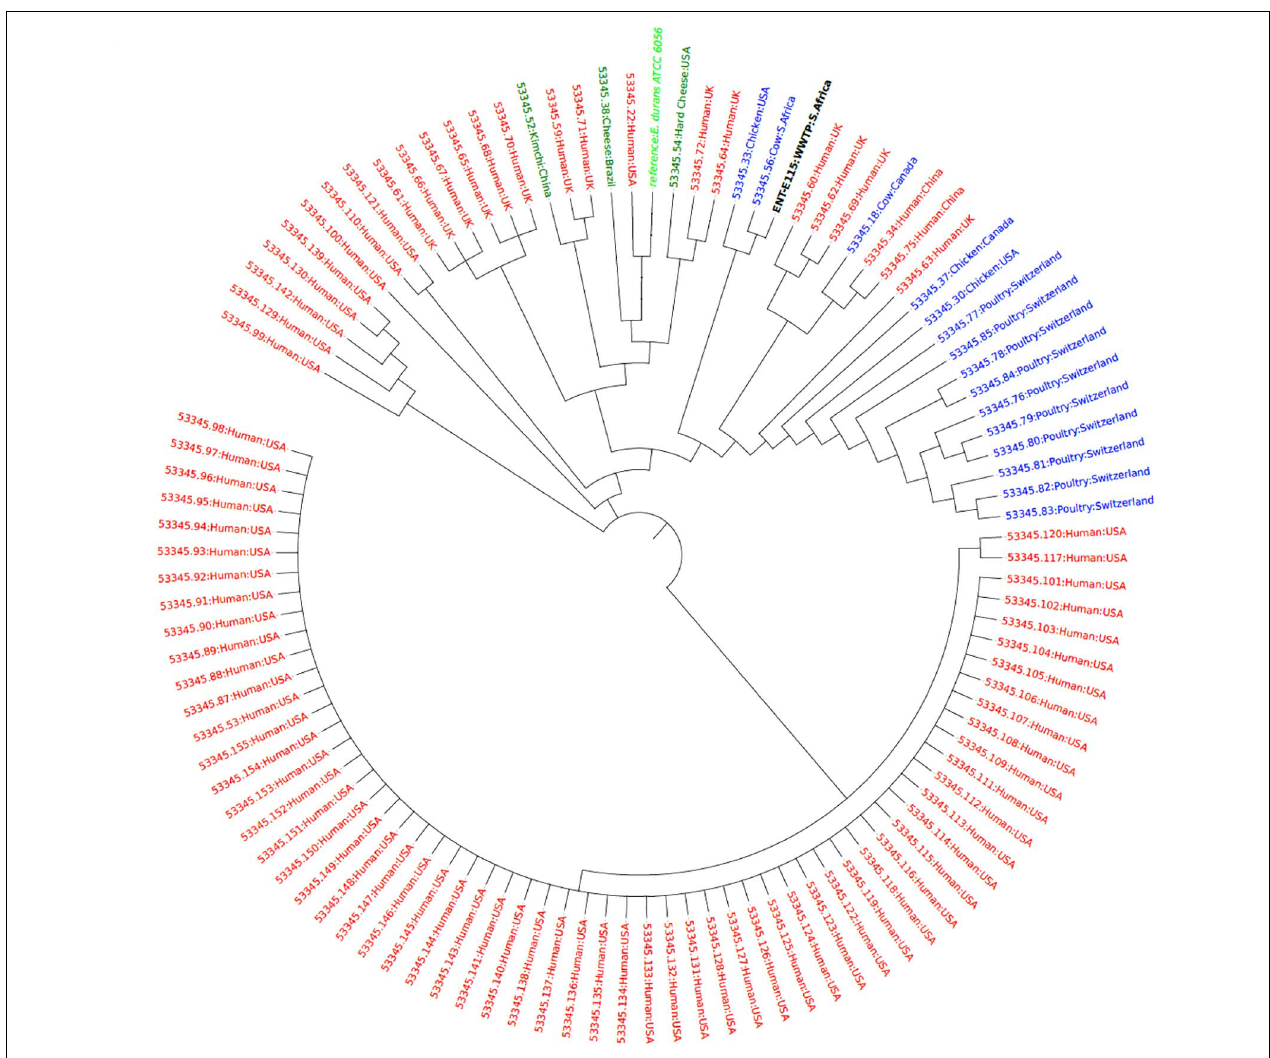
FIGURE 4 | Phylogenetic tree showing the relationship of the E. durans isolate (black label) with other isolates obtained from humans (red), animals (blue), and food sources (green) from the PATRIC database